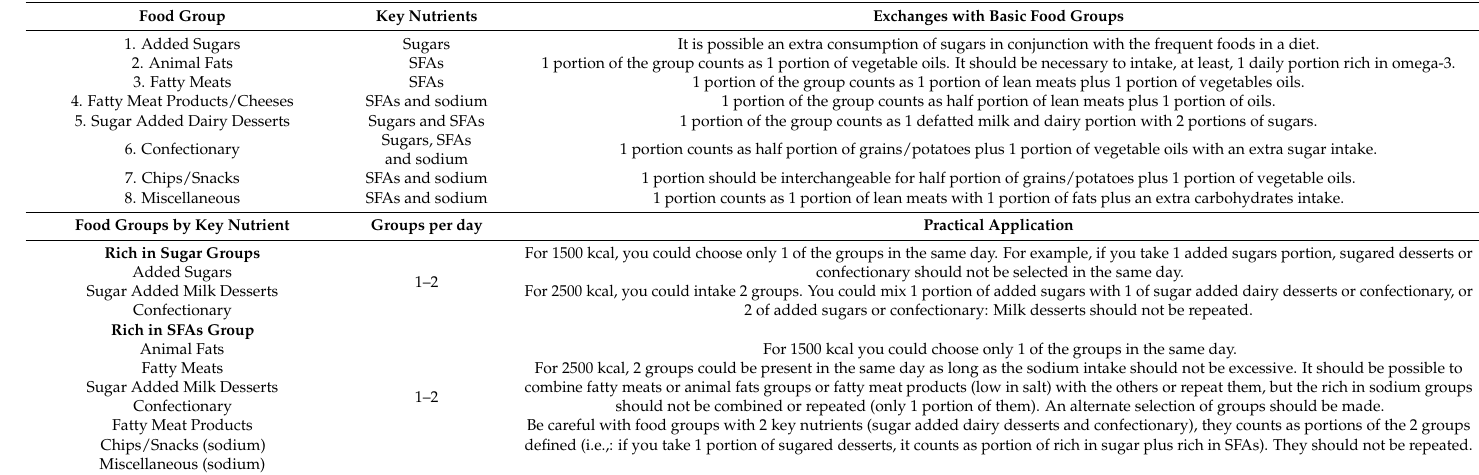
Table 9. Dietary guidelines for occasional food groups according the concerning nutrient per